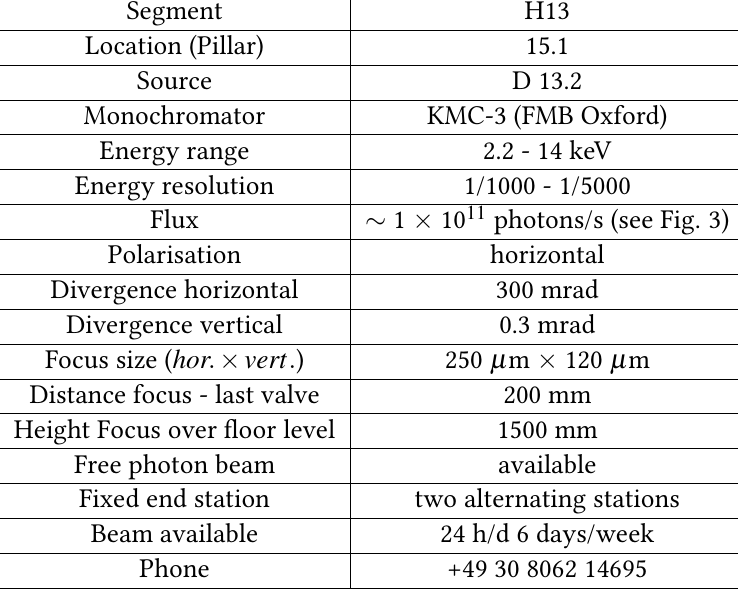
Table 3: Technical data of the KMC-3